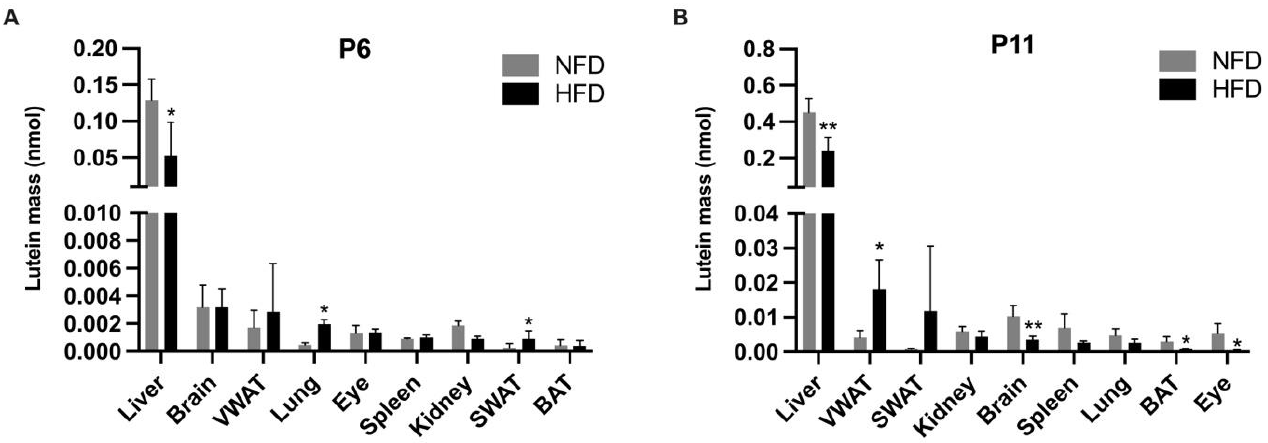
Figure 6. Lutein mass in the tissues of rat pups at postnatal day 6 ( A ) and postnatal day 11 ( B ). Tissues were ranked from the highest to the lowest according to the lutein mass in the high fat diet group. Bars show mean ± SD, n = 7 per group. Significant differences between groups were indicated by *, p < 0.05 and **, p < 0.01. At P2, tissue samples were not adequate for analysis, and therefore, data